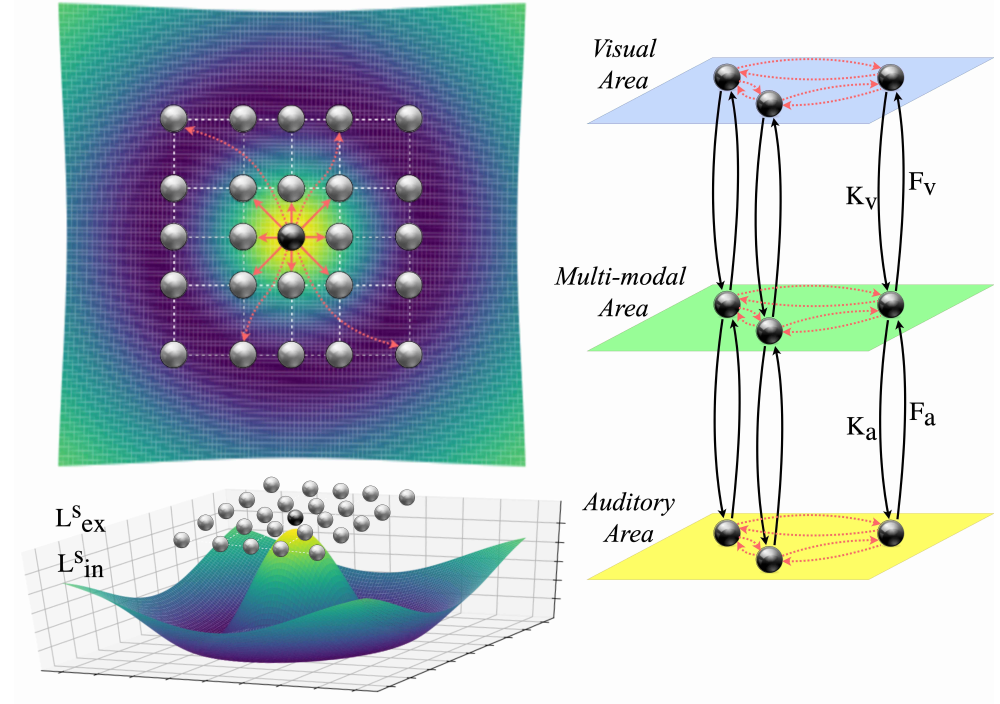
Figure 2. Overall superior colliculus fusion (SCF) layer structure, where the synapses of the central darker neuron (representing neuron ij in a N × M neural area) are modelled after a Mexican Hat wavelet. Each neuron is laterally linked to its area s neighbors by excitatory ex and inhibitory in synapses (red arrows). The described spatially conditional connection between uni-modal neurons (visual/auditory) and their multi-modal counterparts is shown on the